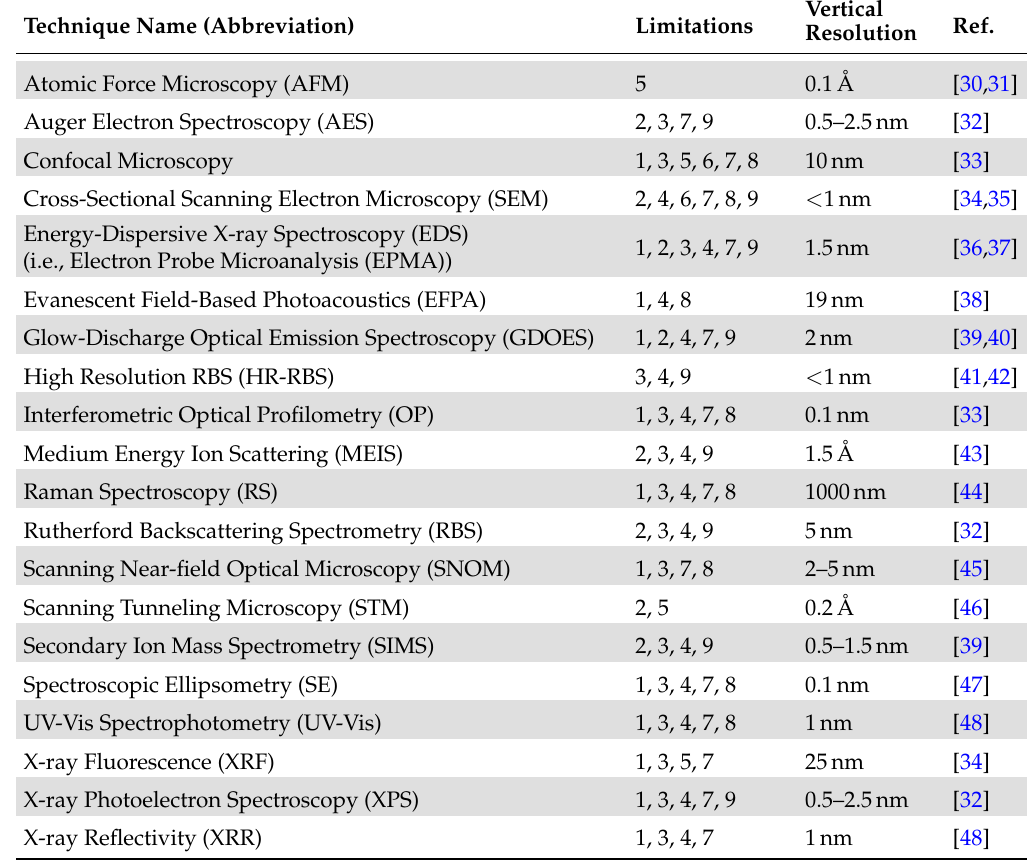
Table 2. A list of techniques that may be used to characterize the thickness of thin films. Although many provide a wealth of data, secondary technologies may be necessary to characterize additional film properties. Measurement limitations are enumerated as follows: (1) radiative absorption; (2) sample conductivity; (3) penetration depth; (4) computationally-derived characteristics; (5) measurement artifacts; (6) contrast requirement; (7) diffraction; (8) sample characteristics (e.g., refractive index); (9) requiring high vacuum